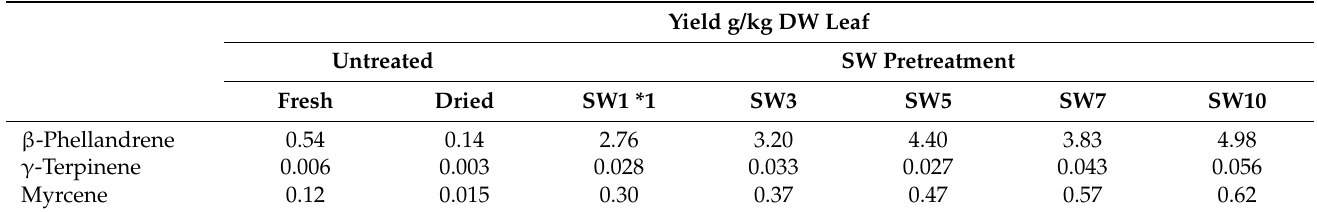
Table 3. Yield of volatile components that effectively removes nitrogen dioxide. Major volatile compounds identified in A. sachalinensis essential